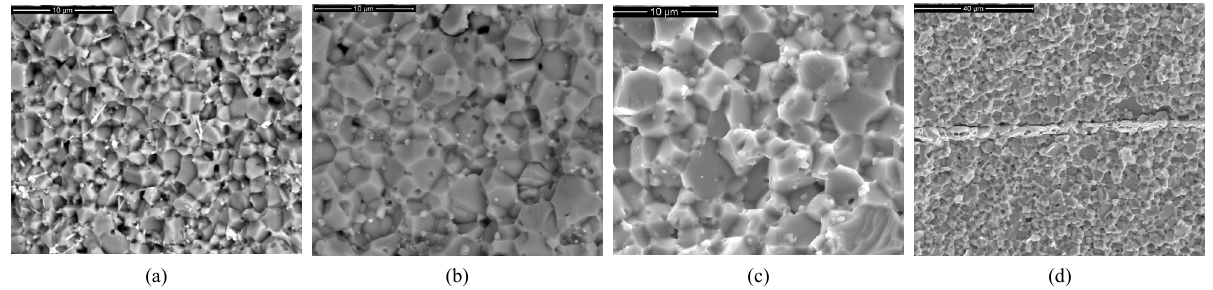
Fig. 3 SEM images of fractured cross-sections of multilayer varistors sintered at various temperatures: (a) 1000 ℃ , 10000×,